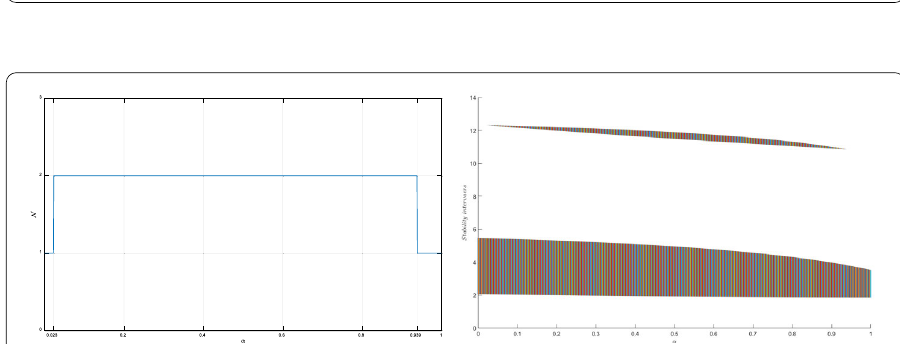
Figure 3 The effect of α when d = 0.13 is fixed. The left panel: the number of stability intervals of system (5.1); the right panel: the distribution of stability intervals of system (5.1). Other parameter values are the same as in Fig.